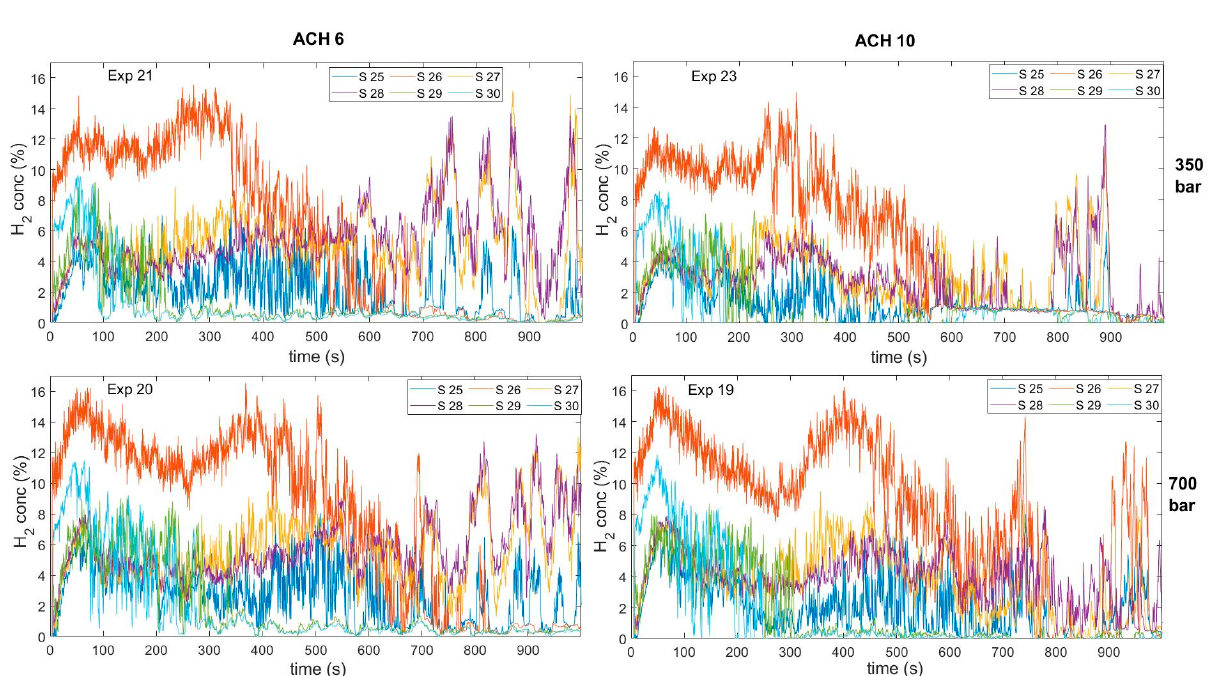
Figure 9. Concentration results from sensors mounted under the car for Experiments 19–21 and 23.